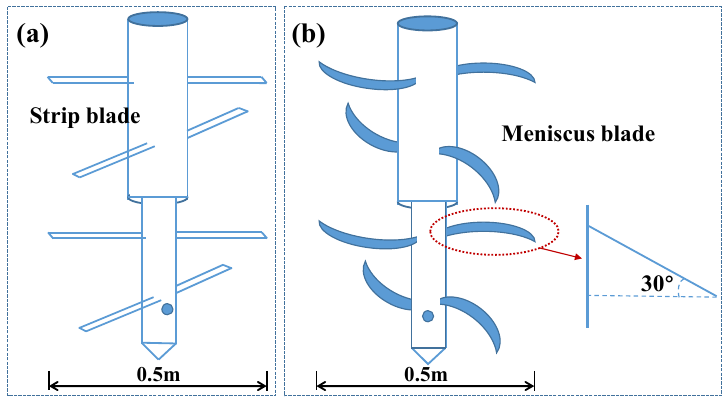
Figure 2. Different shapes of mixing blades: ( a ) strip blade and ( b ) meniscus blade.